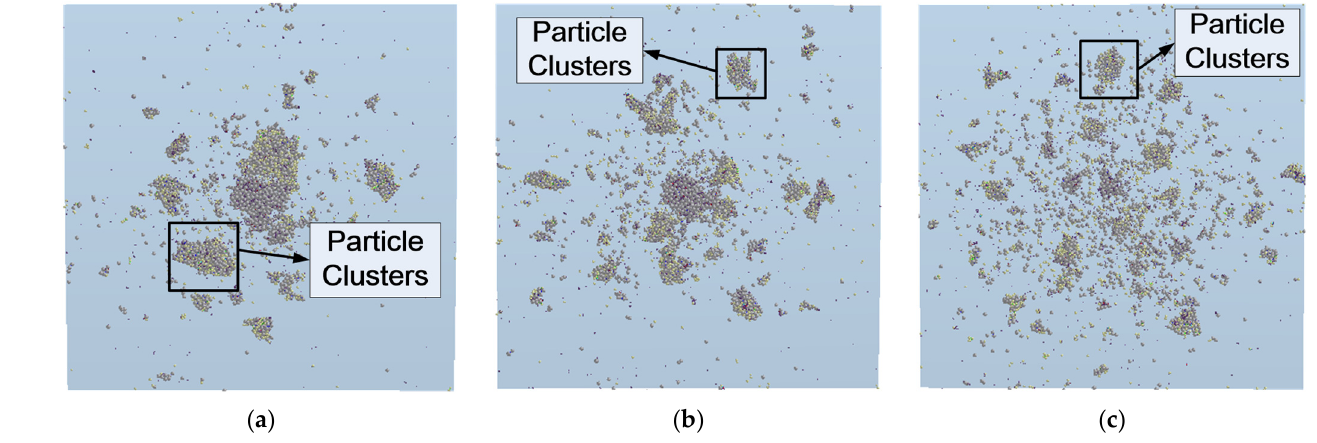
Figure 11. Simulation results under different impact energies. ( a ) E = 0.1 kwh/t; ( b ) E = 0.25 kwh/t; ( c ) E = 1 kwh/t.